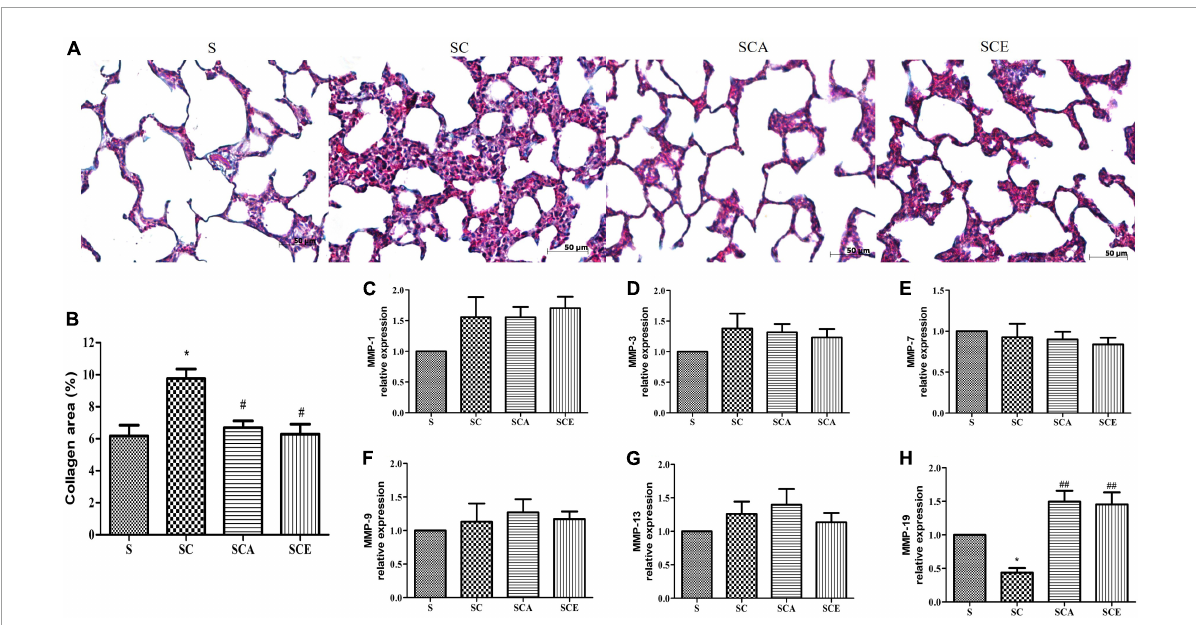
FIGURE6 Effects of atorvastatin and ezetimibe treatment on lung fibrosis and matrix metalloprotease enzyme (MMP) expression in hypercholesterolemic rats. (A) Masson’s trichrome staining; (B) percentage of Masson’s trichrome stained-area; (C) MMP-1 expression; (D) MMP-3